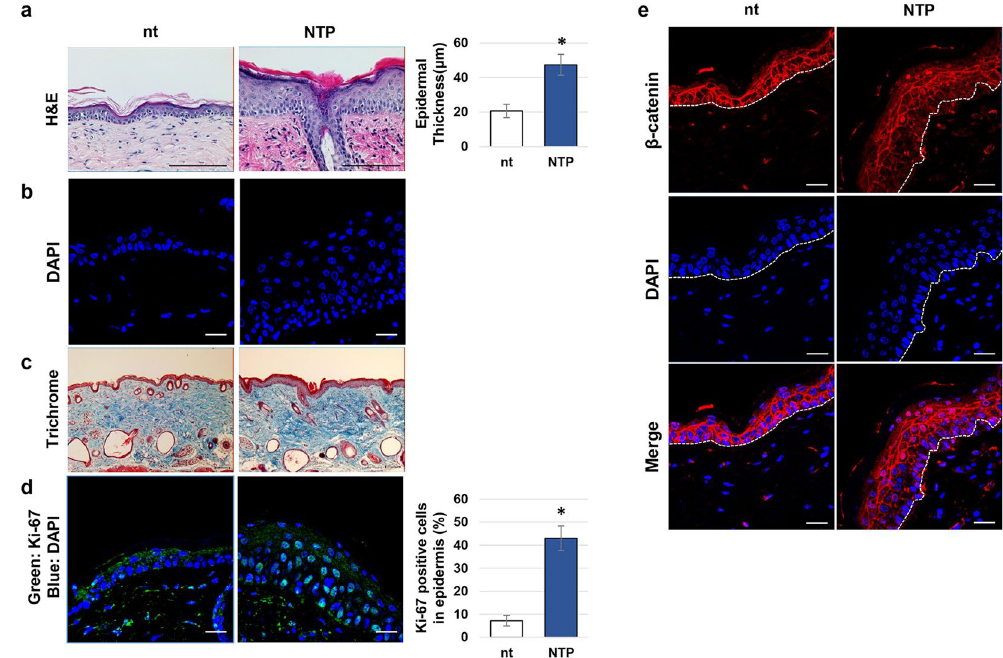
Figure 6. The effect of NTP on epidermal growth. HRM2 mice were subjected to NTP treatment for 5 minutes, three times per week, for 2 weeks. After sacrificing the mice, the tissues were subjected to histological analysis. ( a ) Results of H&E staining, scale bar: 100 μ m. The epidermal thickness from 4 independent experiments was calculated and averaged, presented as graph (right panel), p < 0.01. ( b ) The results of DAPI staining, scale bar: 20 μ m. ( c ) Results of trichrome staining, scale bar: 100 μ m. ( d ) Results of immunofluorescence staining against Ki-67, and the percentage of Ki-67-positive cells were presented as a graph (right panel). The data shown are representative of four independent experiments. Scale bar: 20 μ m, * p < 0.005. ( e ) NTP-treated or non-treated tissues (nt) were subjected to immunofluorescence staining of β -catenin (red), DAPI counterstaining of the nuclei (blue), and confocal microscopic images were taken (scale bar: 20 μ